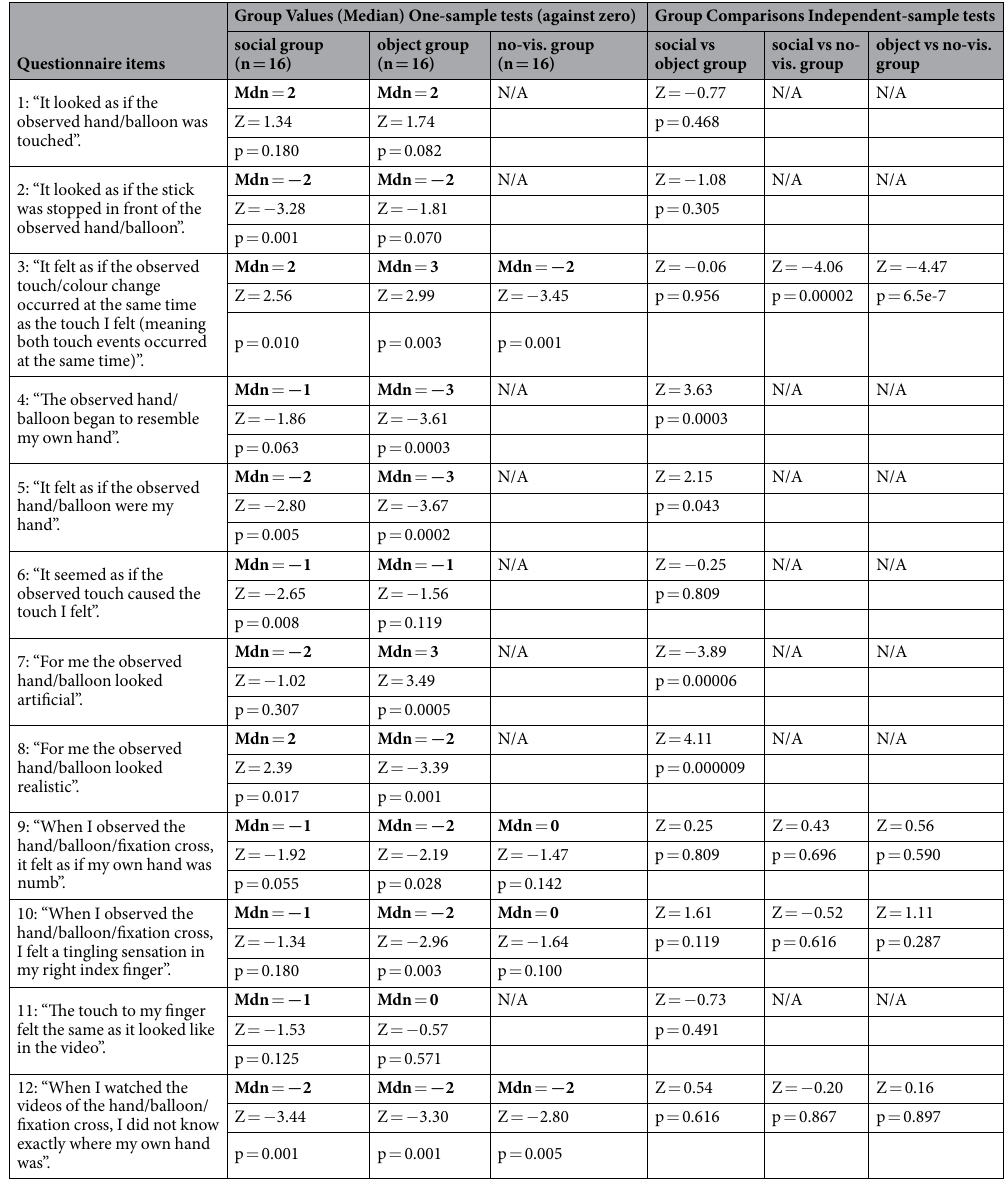
Table 1. Summary of questionnaire items and answers. Participants were asked to rate 12 (social group and object group), or 4 (no-vision group) statements on a bipolar seven-point scale ranging from − 3 (strong contradiction) to + 3 (strong agreement). Group values are given as group medians (Mdn). We calculated non- parametric one-sample Wilcoxon signed rank-tests to test group medians against zero (neutral answer), and independent-sample Mann-Whitney U-Tests to compare item distributions between groups. Standardised test statistics (Z) and p-values (p) are given for computed